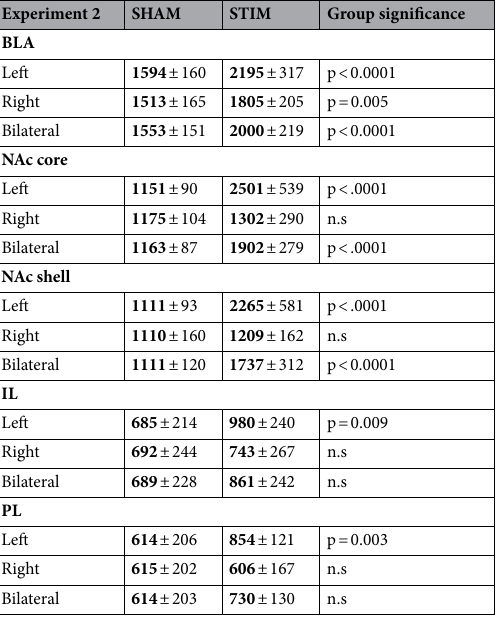
Table 1. Overview of neuronal c-Fos intensities in Experiment 2. Data are shown as means ± standard deviations for each hemisphere. Significances of the ‘Group’ effect are listed in the right-hand column. BLA basolateral amygdala, NAc nucleus accumbens, IL infralimbic cortex, PL prelimbic cortex, n.s. not significant (p > 0.05).